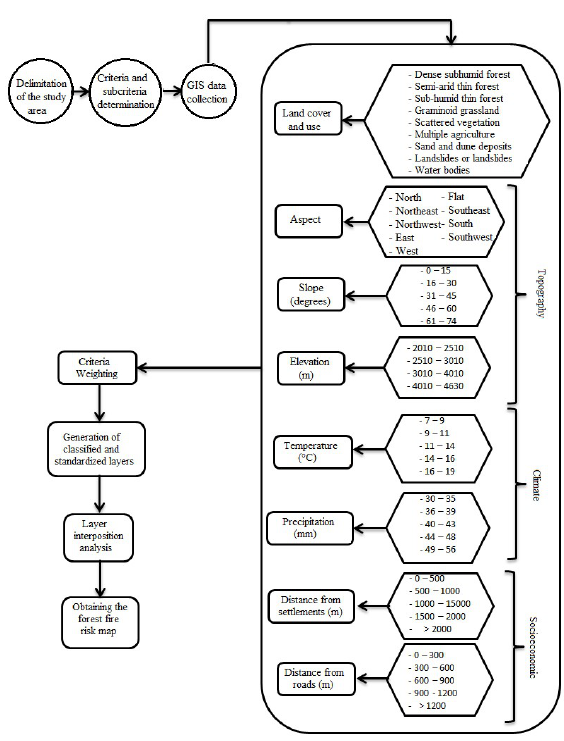
Figure 1. Summary of the